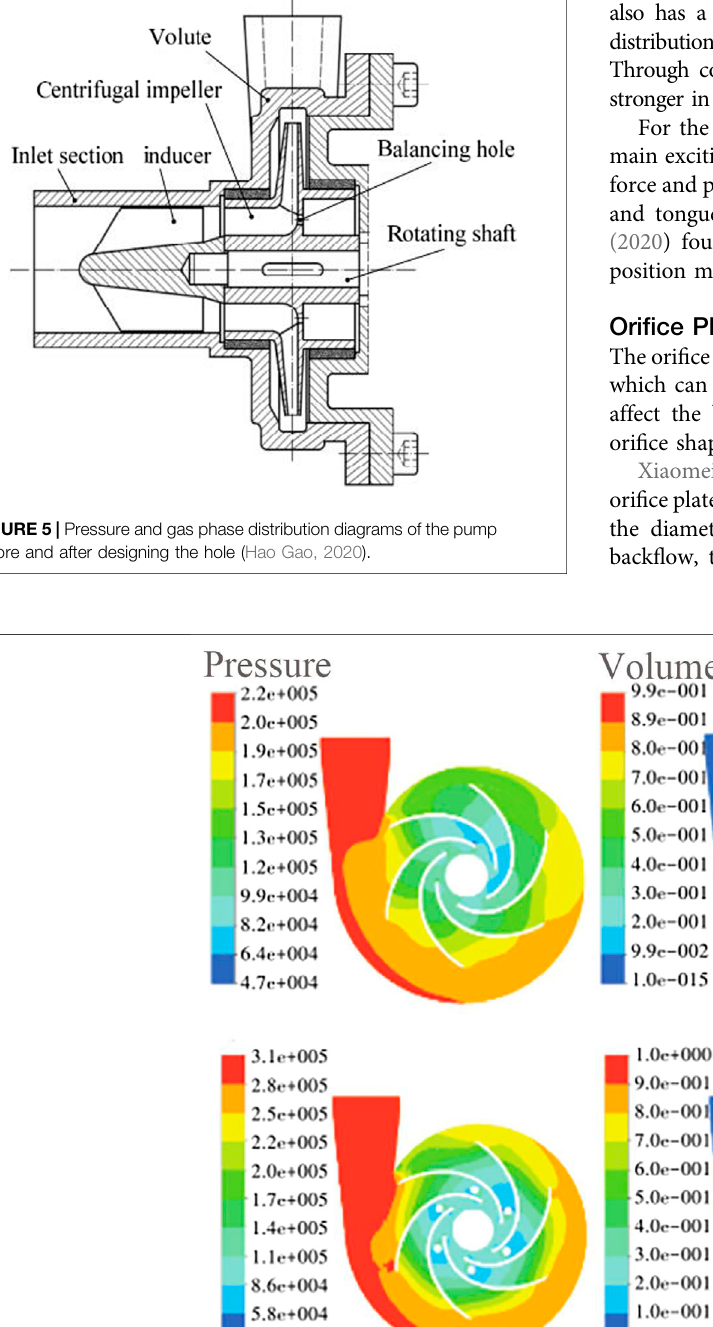
Frontiers in Energy Research |